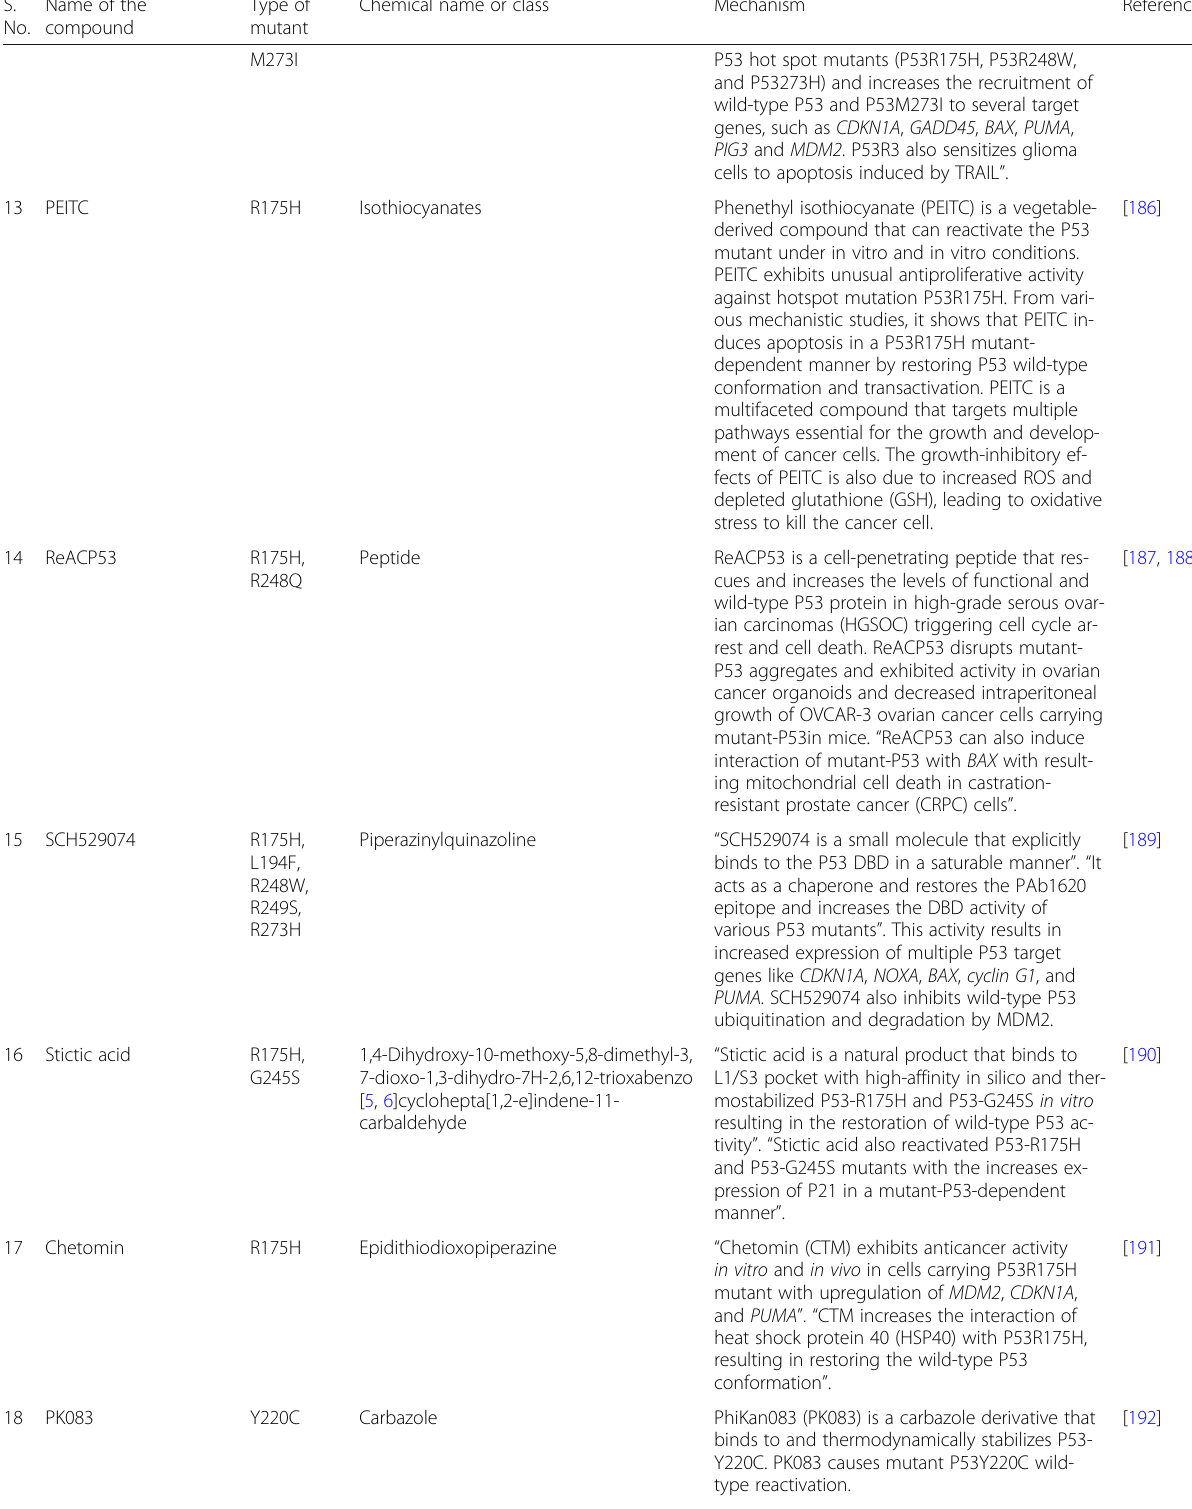
Table 1 Compounds that target mutant P53 and induce reactivation